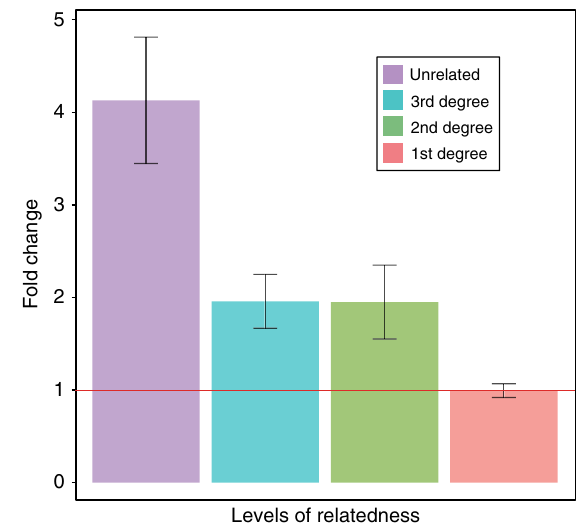
Fig. 4 The ratio of the empirical prediction accuracies between large- and small-scale design. The empirical prediction accuracy of the large-scale design is compared to that of the small-scale design for each level of relatedness. The main bars represent the mean values of ratios averaged over the analyses of 50 traits. The error bars show the 95% con fi dence intervals of the mean ratios. The red horizontal line indicates a ratio of